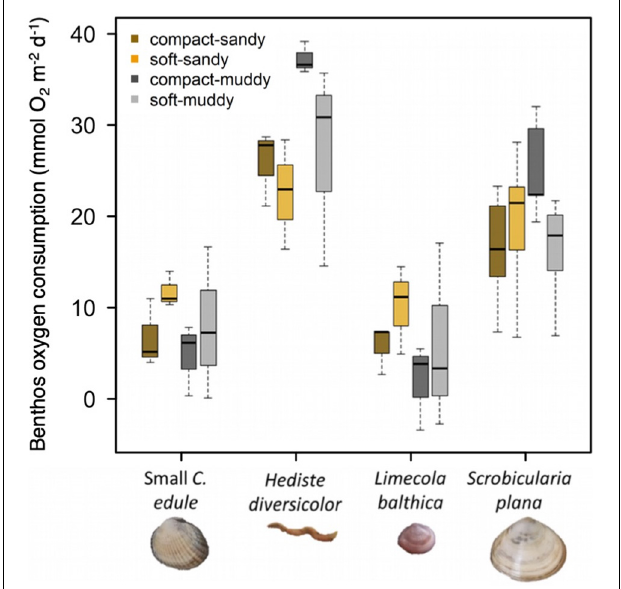
FIGURE 5 | Oxygen consumption rate for species by sediment treatment represented by boxplots where the box (25–75% of the data) contains a black line (median) and has whiskers extending to the minimum and maximum data values. Large C. edule and A. marina were not included in the experiment due to equipment limitations. We pooled the results for the large and small S. plana because they were so similar. Since the microbial respiration was different in the sandy vs. muddy sediment, we corrected the values of animal respiration obtained from the sediment cores by subtracting the mean respiration value of controls which represent the microbial respiration. 13.3 mmol O 2 m − 2 d − 1 were subtracted from sandy treatments, 20.7 mmol O 2 m − 2 d − 1 were subtracted from muddy sediments. There were no significant sediment treatment